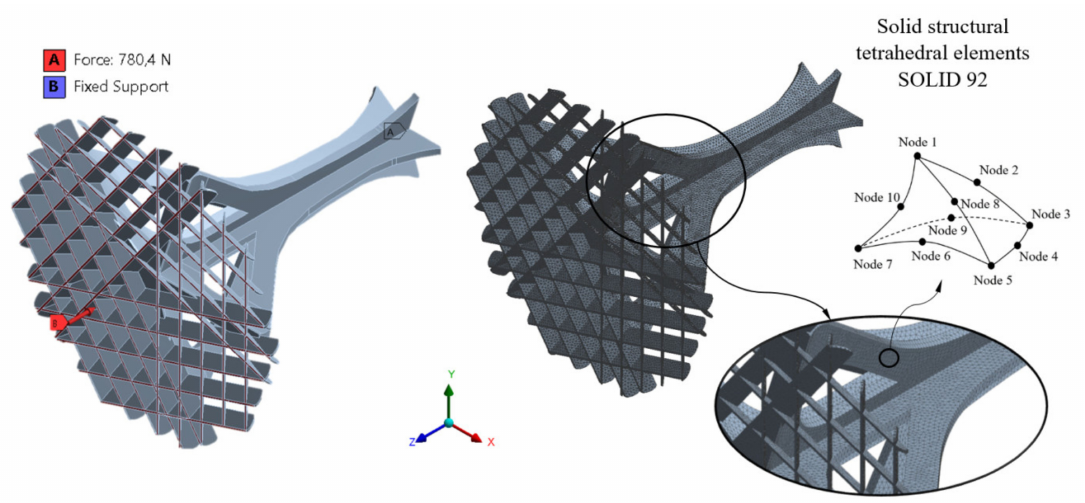
Figure 7. Boundary requirements and loads and mesh generated for the numerical simulations of the structural element.